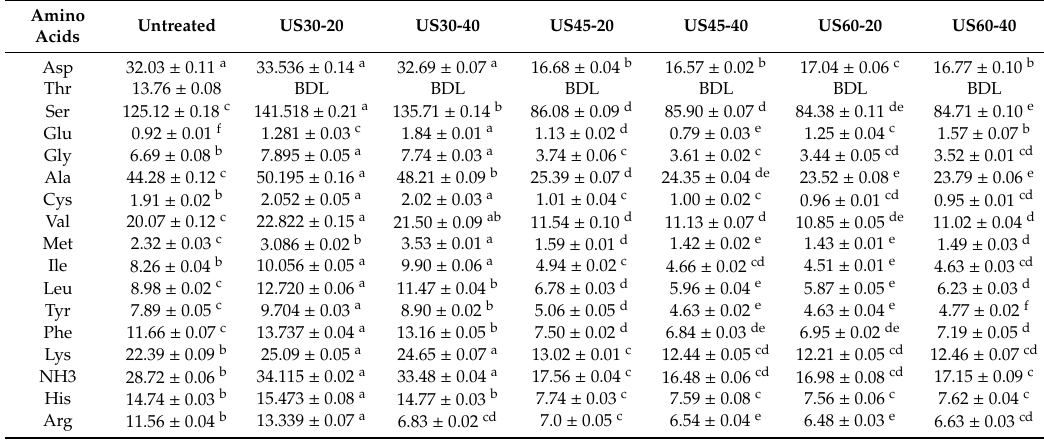
Table 5. Impact of TU treatment on amino acids profile (mg / 100 mL).